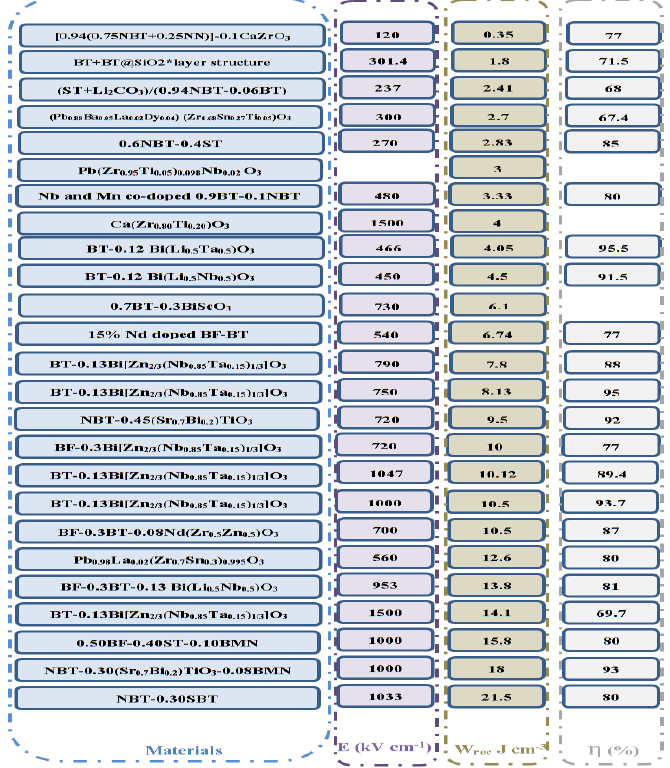
Figure 4. Summary of MLCCs’ energy -storage characteristics [46,49,57,80 – 101].